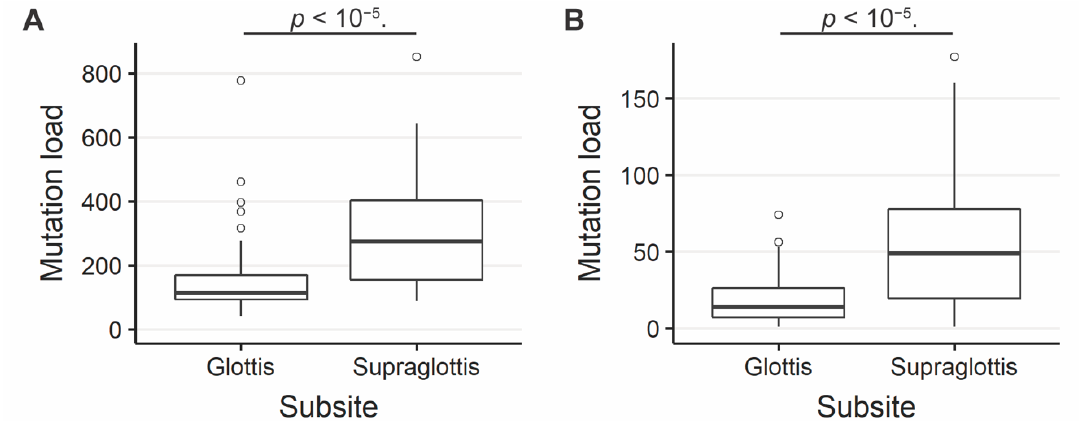
Figure 1. ( A ) Overall SNV mutation load in supraglottic and glottic LSCC. Glottis median value 113.0, interquartile range (IQR) 76.0; supraglottis median 273.0, IQR 247.5. ( B ) G>T SNV mutation load in supraglottic and glottic LSCC. Glottis median 13.50, IQR 19.00; supraglottis median 48.5, IQR 58.25. The number of SNVs per tumor differs significantly between supraglottic and glottic LSCC ( p < 10 − 5 ).